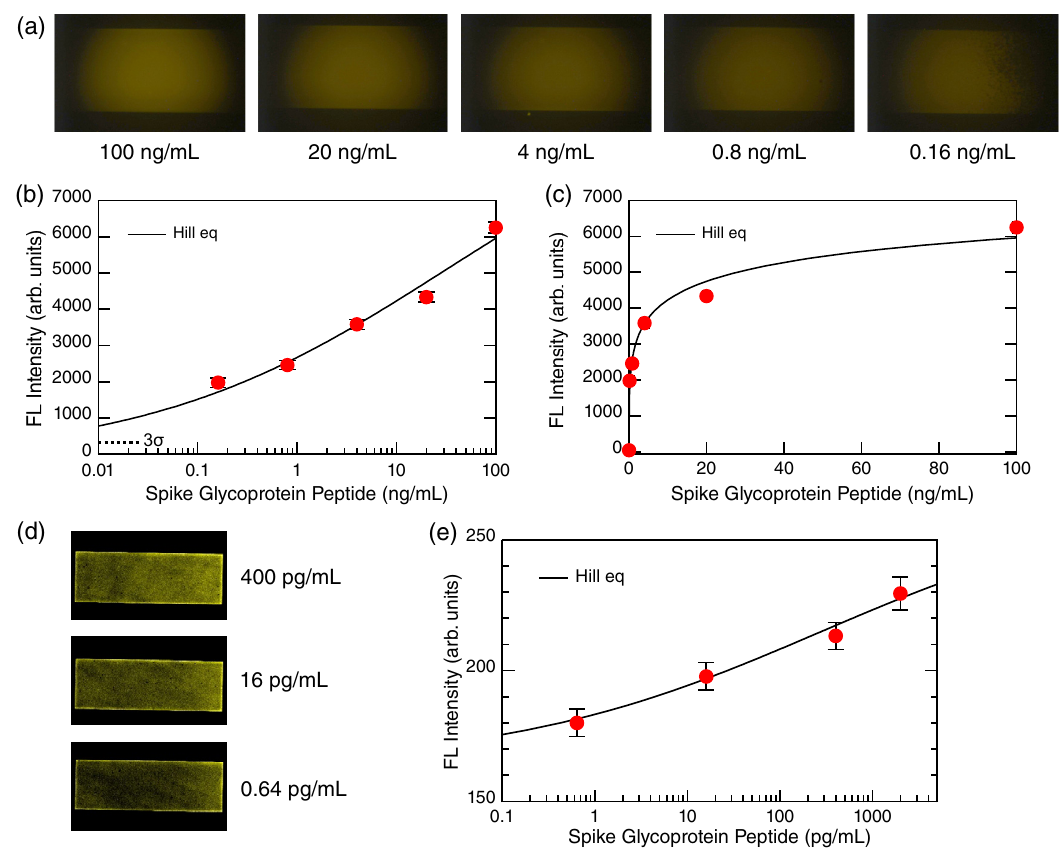
Figure 3. Glycoprotein detection. ( a ) FL images (raw color) of the target concentration from 100 to 0.16 ng/mL. ( b ) Detection data plot in the semi-logarithmic representation. Red dots indicate the FL intensities extracted from the images in ( a ). Error bars are shown together. The solid curve is a fitted curve following the Hill equation (Equation (1)). The level of 3 σ from zero is indicated by the dotted line. ( c ) The detection data plot is shown in a linear representation with data in common with ( b ), except for the data point at 0 ng/mL. ( d ) Confocal FL images at low concentrations from 400 to 0.64 pg/mL are shown. The images were originally grayscale, shown by pseudocolor. The colored rectangular areas of 2.1 × 0.7 mm 2 correspond to the metasurfaces. The MF flow was conducted from right to left. ( e ) Detection curve obtained from the confocal images. Note that the abscissa is in units of pg/mL. A curve fitted by the Hill equation (Equation (1)) is shown with the black